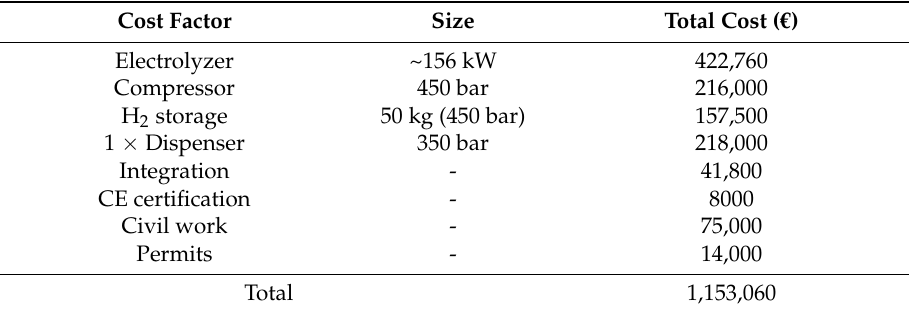
Table 1. Investment expenses without VAT.